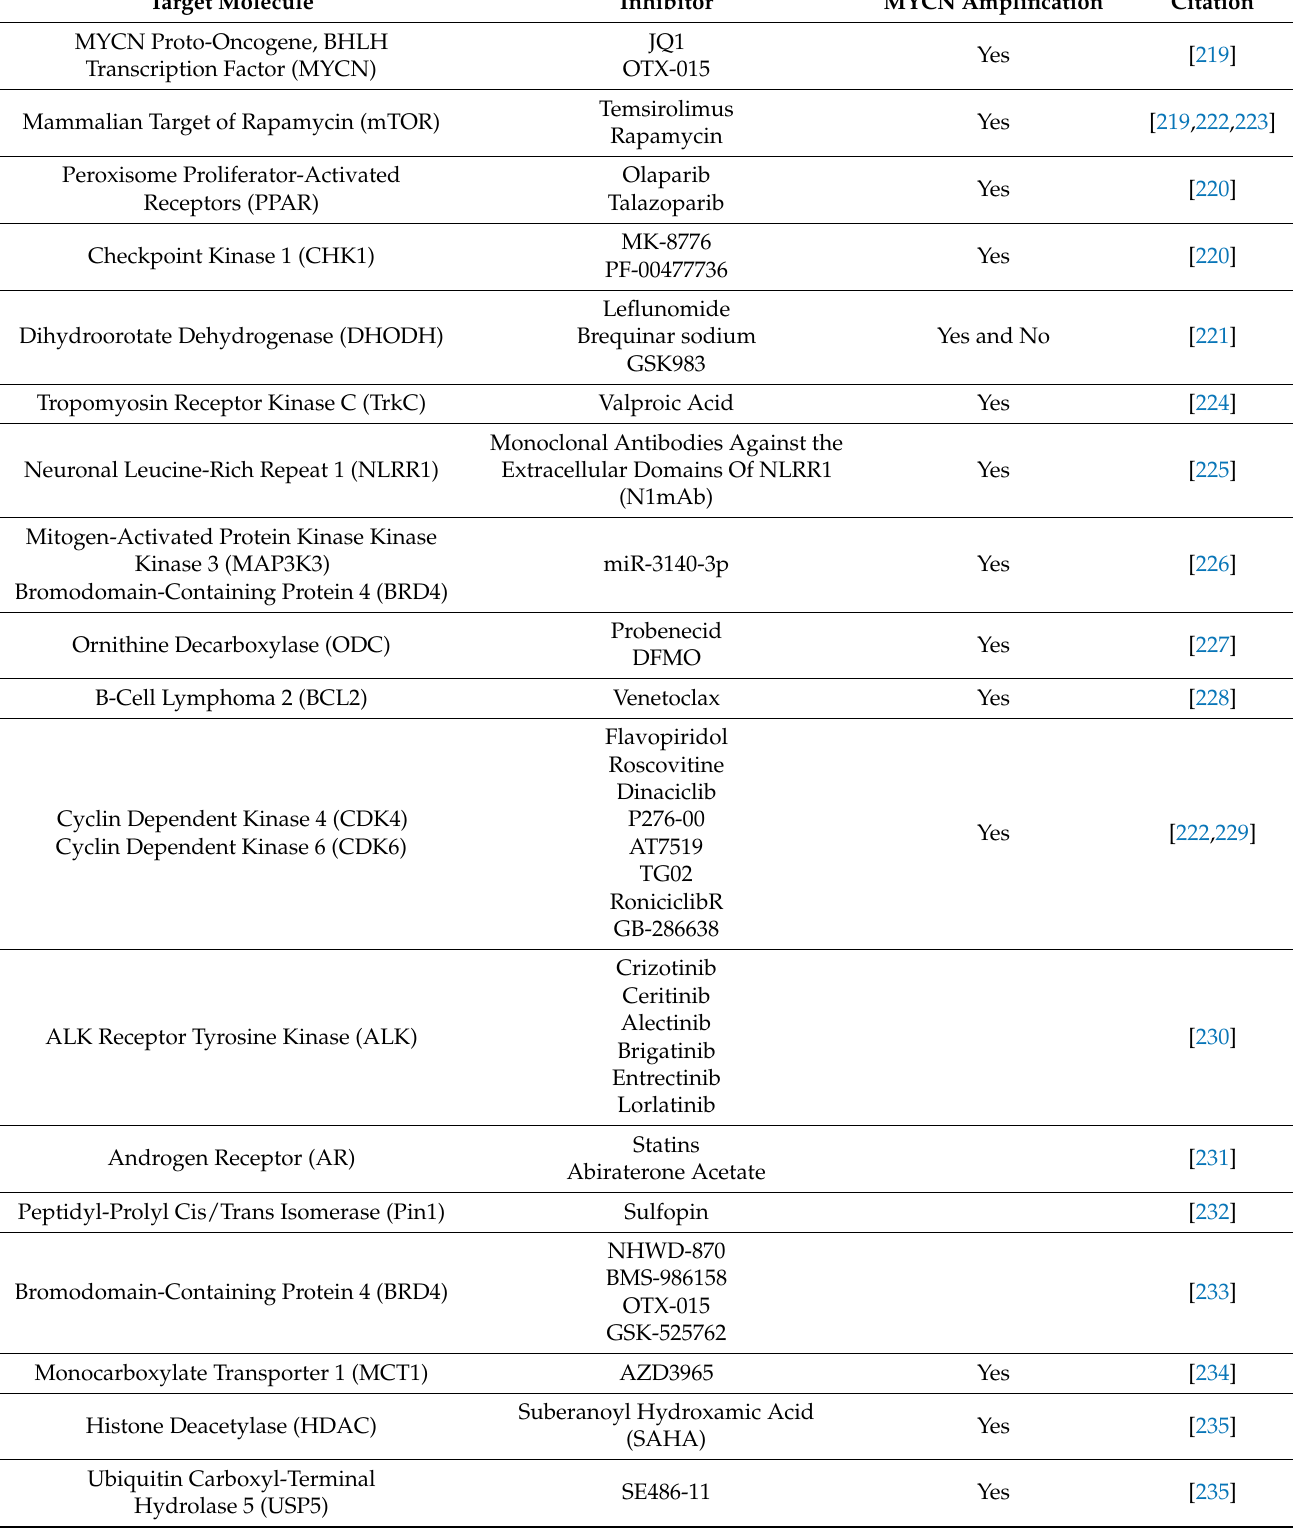
Table 5. Therapeutic targets in